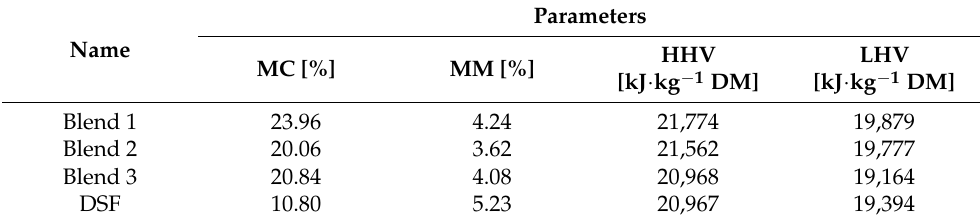
Table 2. Properties of solid biofuels.